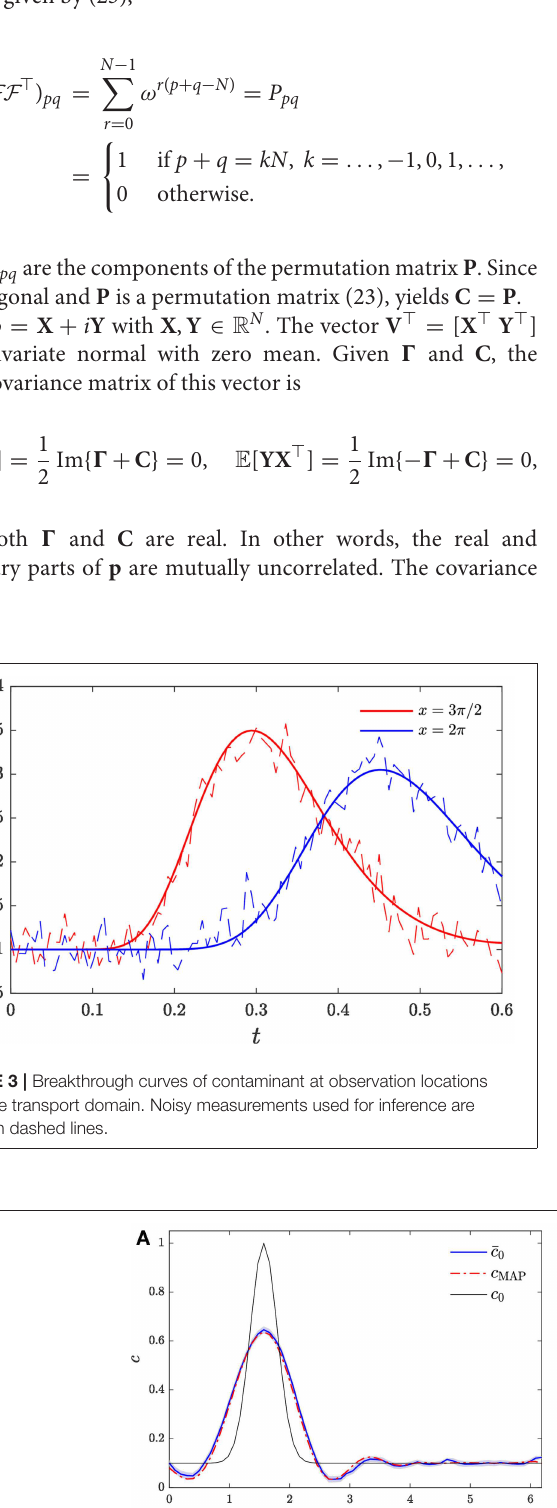
FIGURE 4 | Reconstruction of release profile via gHMC and A (B) Posterior standard deviation.